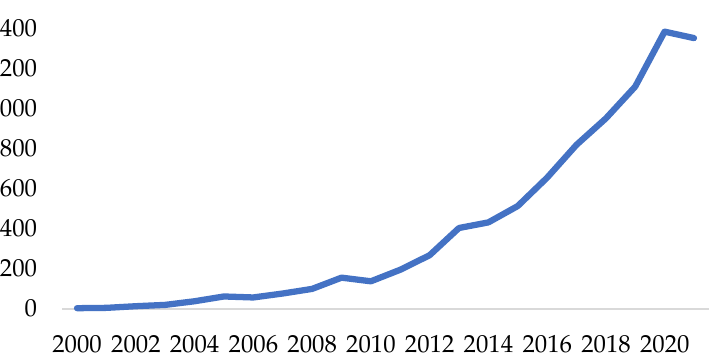
Figure 3. Number of documents per year from 2000 to 2021 based on the Scopus